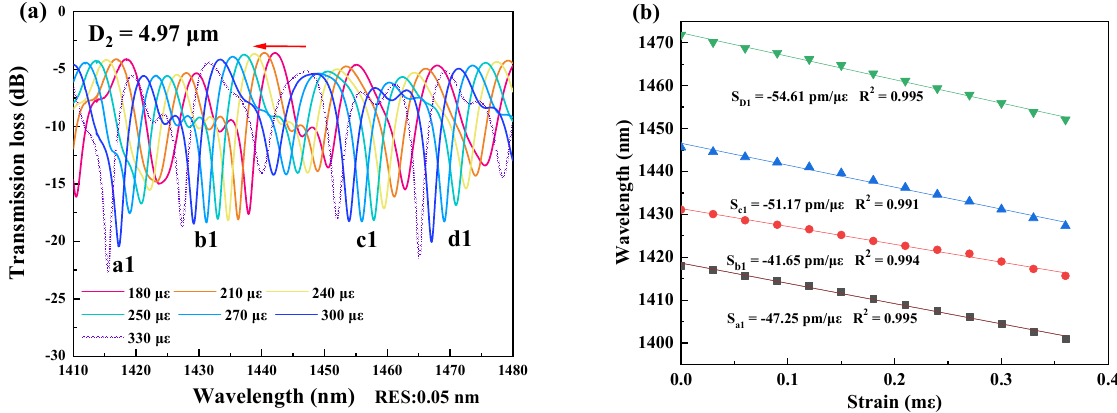
Figure 3. ( a ) Spectral responses of the interferometer with D 2 = 4.97 μm in the strain range of 180–330 με at 1410–1480 nm. ( b ) Linear fitting curves of the dip wavelength shifts and the coefficients of determination R 2 of linear fitting with D 2 = 4.97 μm.